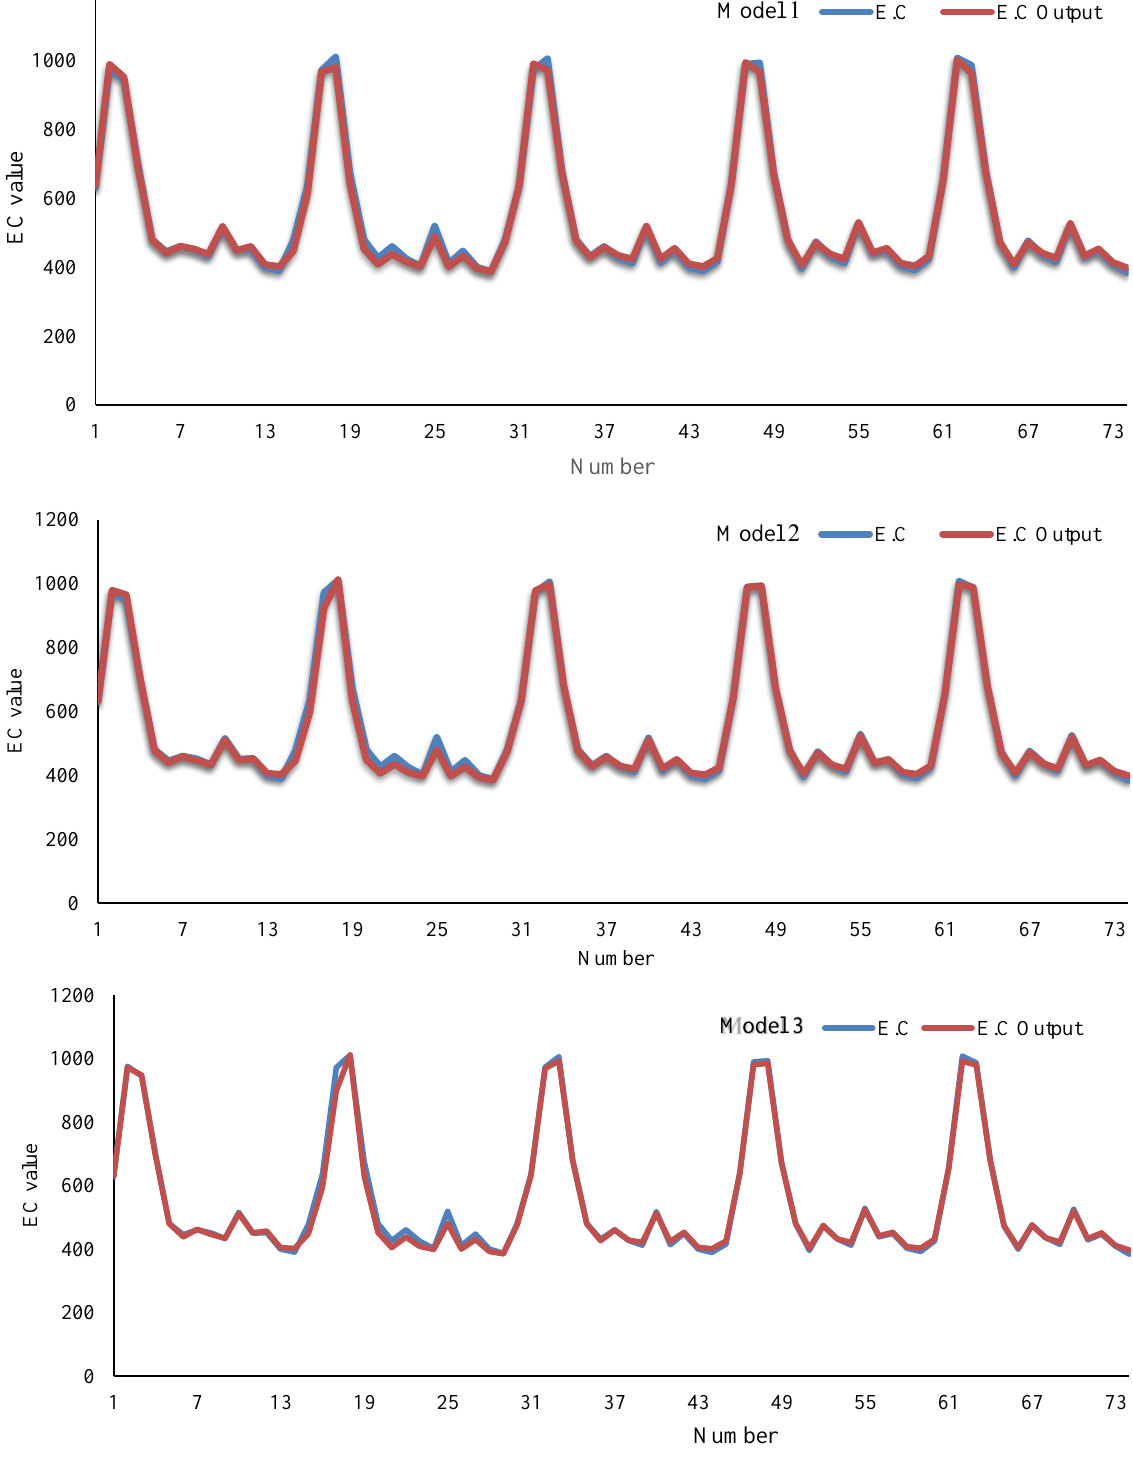
Fi g. 6 . Overlap graph of predicted values by models with actual